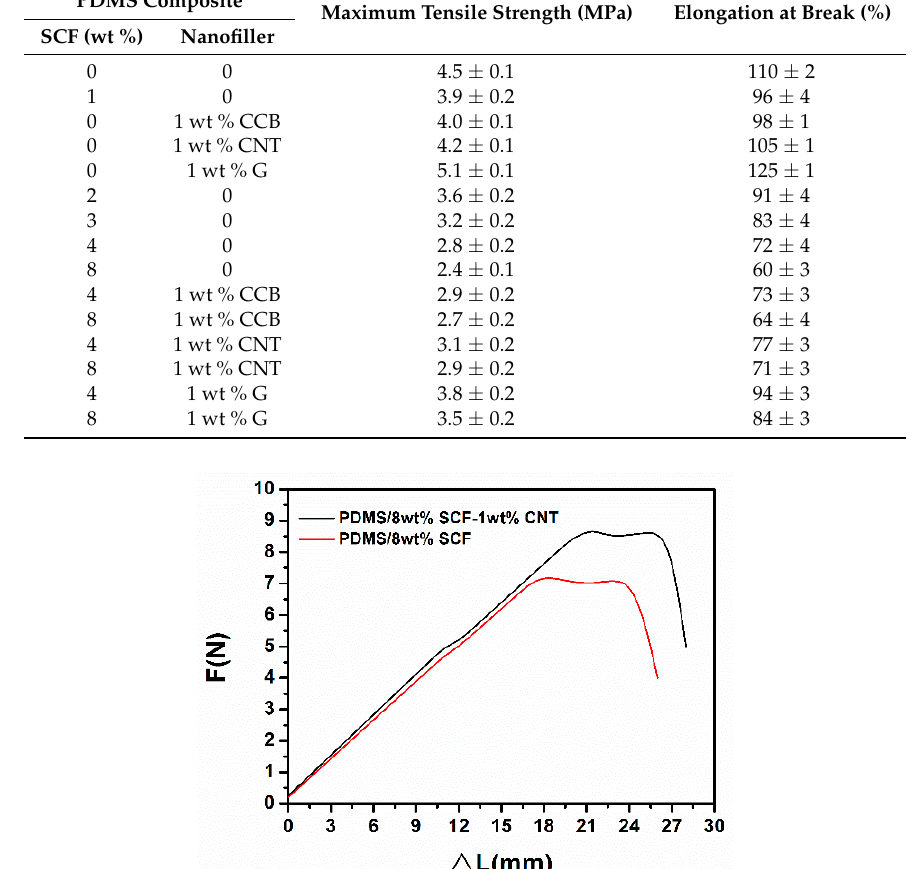
Table 2. Mechanical properties of PDMS composites at thickness 0.2 mm.